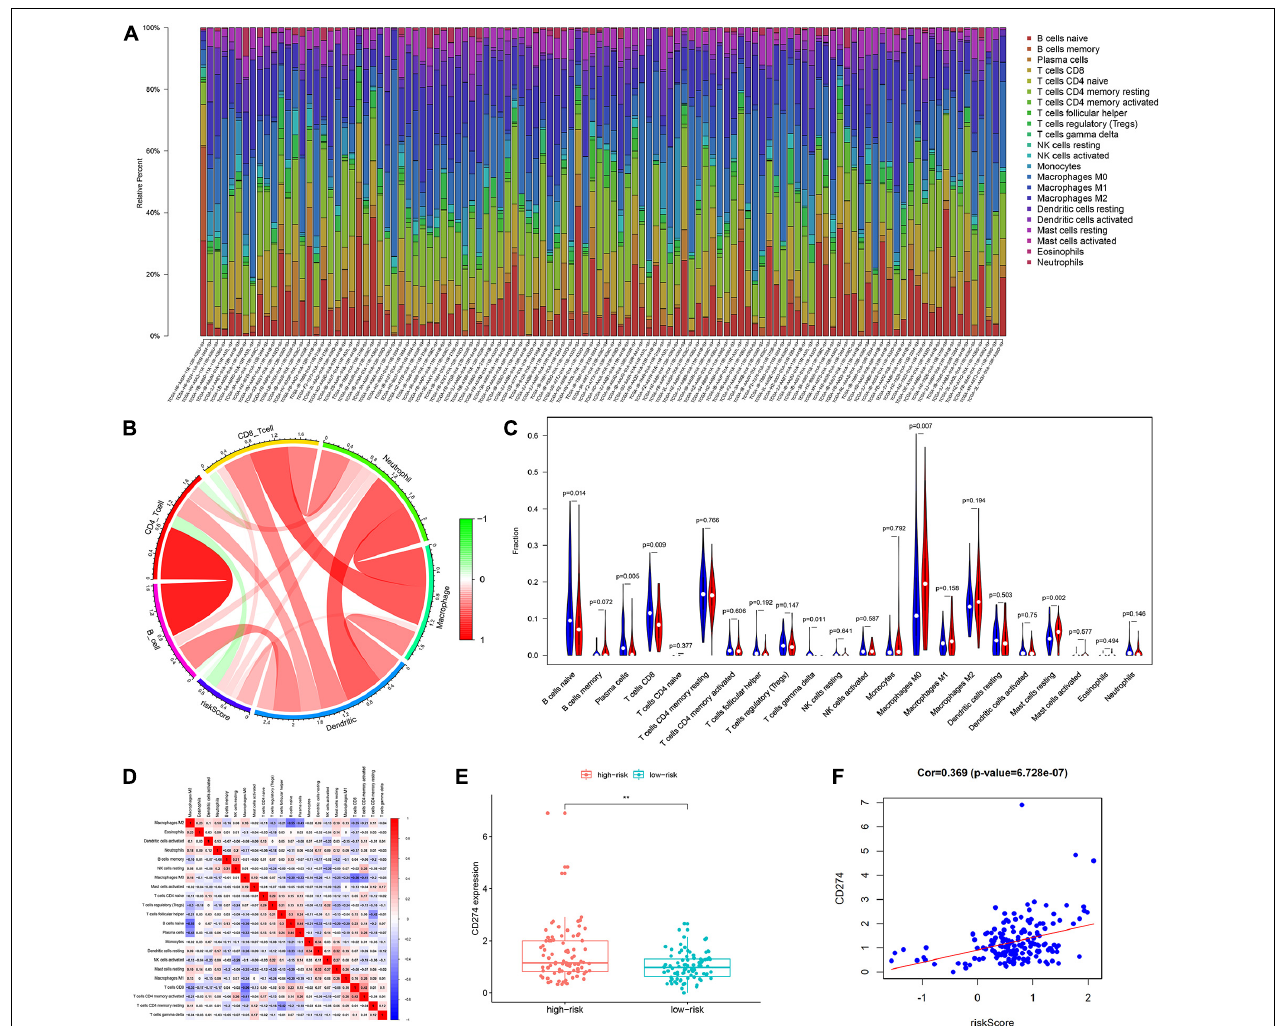
FIGURE 9 | The landscape of immune infiltration in high- and low-risk HCC patients. (A) The bar plot of immune infiltration in high- and low-risk HCC patients (B) Correlation of the risk score with the immune infiltration of six kinds of immune cells (TIMER method). (C) Violin plots visualizing significantly different immune cells between high-risk and low-risk patients (CIBERSORT method,red represents the high-risk group, blue represents the low-risk group). (D) Correlation matrix of all 22 immune cells proportions. (E) Boxplot plot of the expression level of CD274 between high-risk and low-risk patients. (F) Correlation of the risk score with the expression of CD274 ( p -value significant codes: 0 ≤ ∗∗∗ < 0.001 ≤ ∗∗ < 0.01 ≤ ∗ <